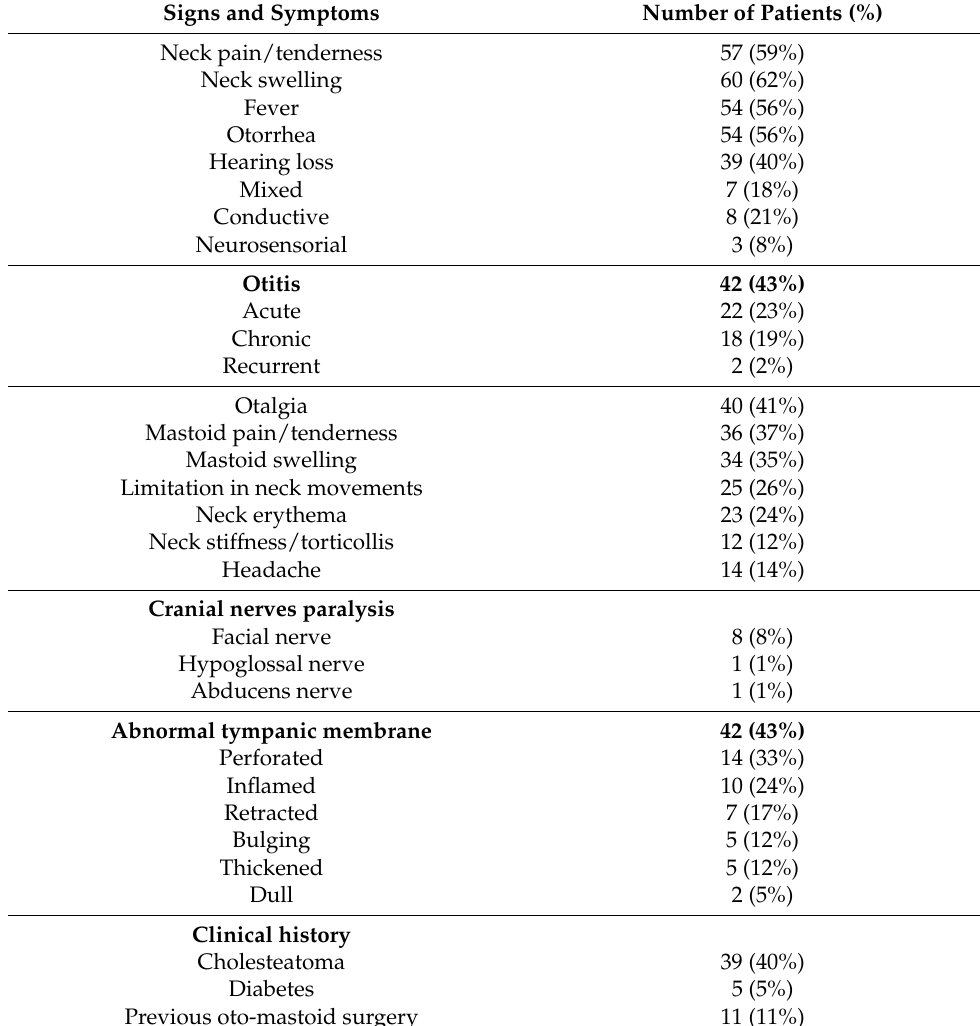
Table 2. Clinical presentation of Bezold’s